Question: Name the type of graph shown.
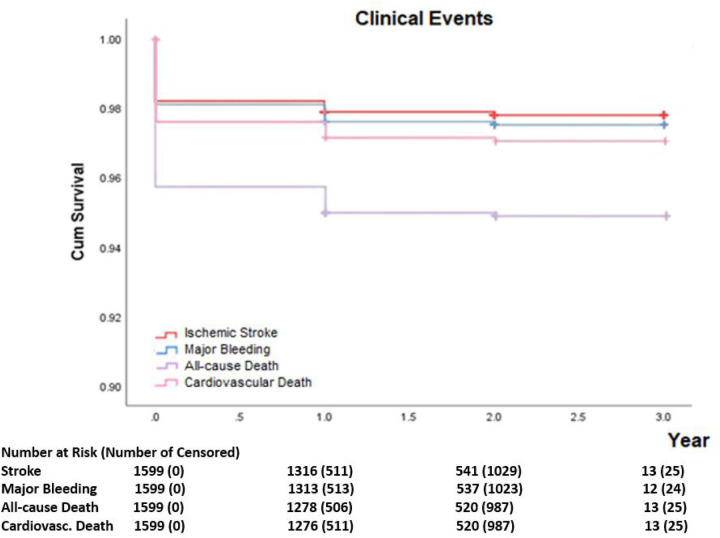
Answer: survival